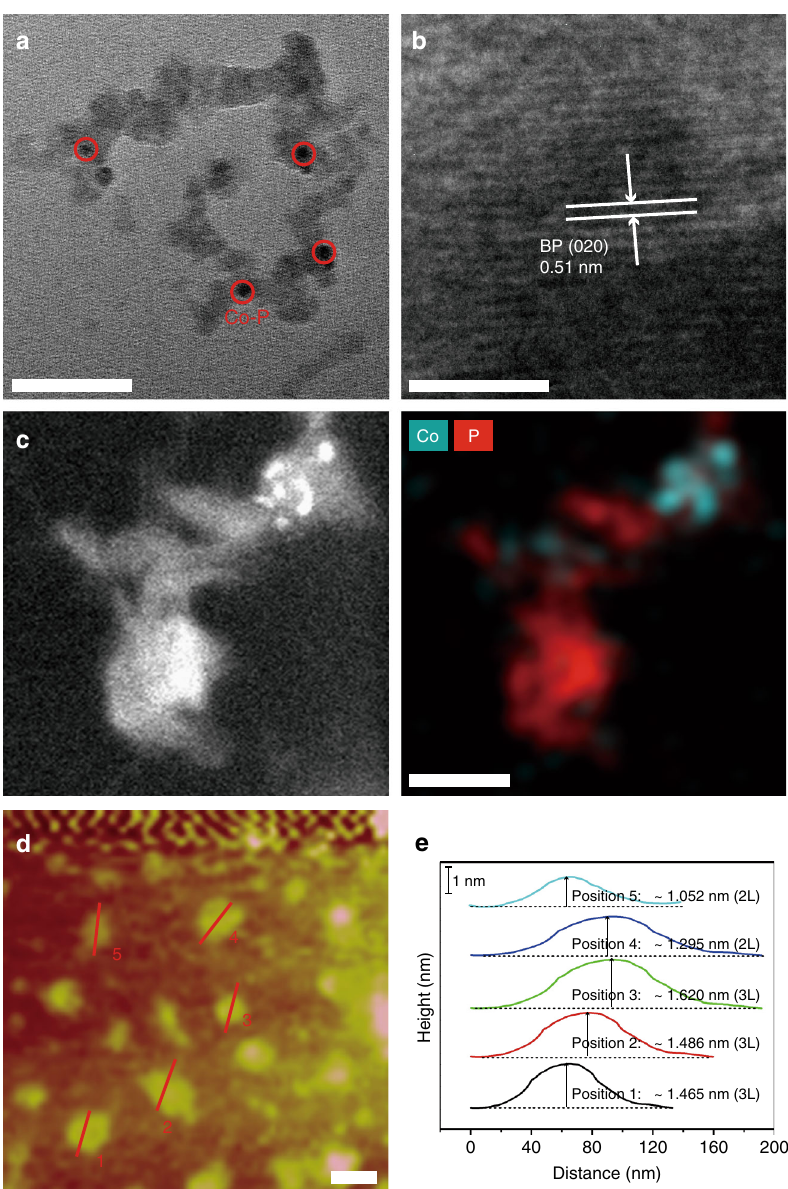
Fig. 2 Morphology and structure of the Co-P/BP nanosheets. a , b TEM and HRTEM images of the Co-P/BP nanosheets. The red circles marked are amorphous Co-P nanoparticles and the nanosheet structure is BP. c EDX element mapping. The high-angle annular dark fi elds (HAADF) scanning transmission electron microscope (STEM) of the region of interest, as well as Co and P distribution, are shown. d , e AFM image and the corresponding height pro fi les of the Co-P/BP nanosheets. The scale bars are 50, 5, 40, and 20 nm in Fig. 2a, b, c, and d, respectively. In all panels, the mass ratio of P to Co is about